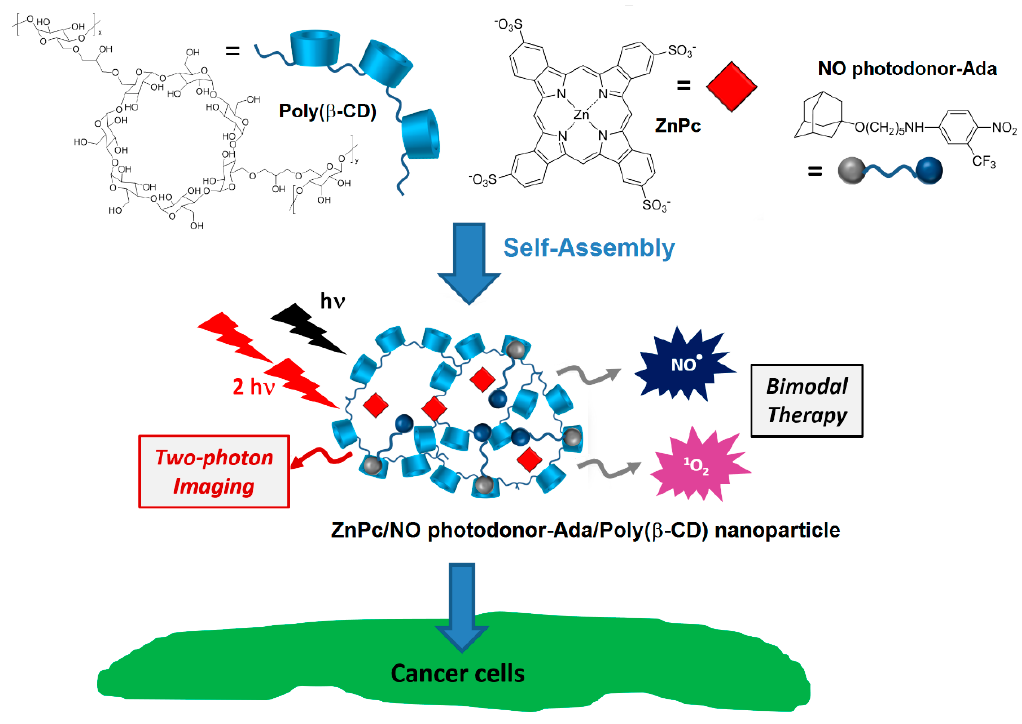
Figure 45. Molecular structure of Poly( β -CD), ZnPc, an NO photodonor attached to an adamantane moiety (NO photodonor-Ada), and corresponding ZnPc/NO photodonor-Ada/Poly( β -CD) nanoparticle. Adapted from Kandoth; Kirejev; Monti; Gref; Ericson; Sortino [178].